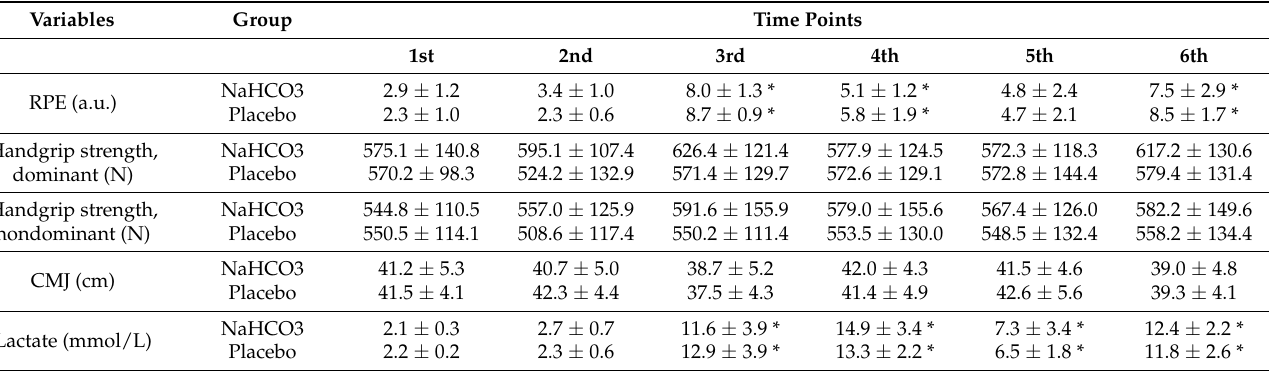
Table 1. Descriptive statistics of the variables